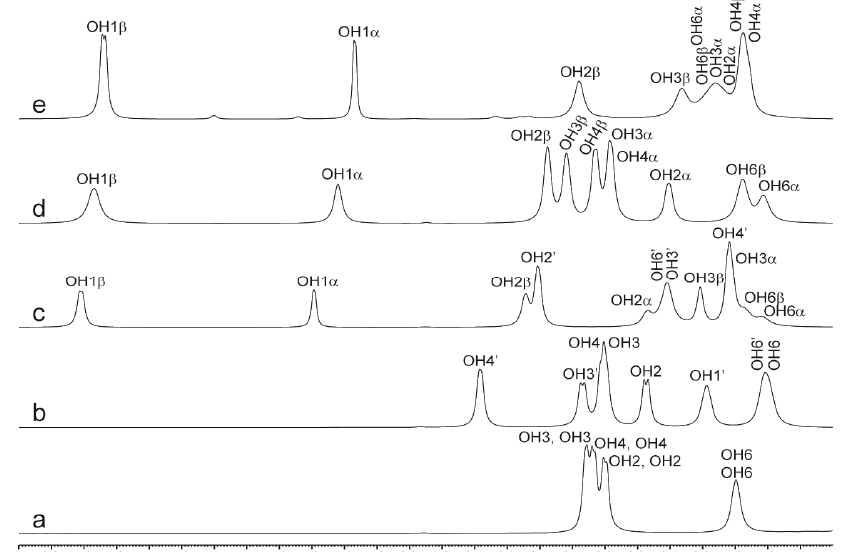
Figure 4. ( a ) 1 H NMR spectra of the hydroxy proton region of ( a ) trehalose, ( b ) sucrose, ( c ) lactose, ( d ) glucose and ( e ) galactose at − 5 °C in 90% H large upfield shifts of GlcOH3( α / β ) in spectrum c compared to spectrum d